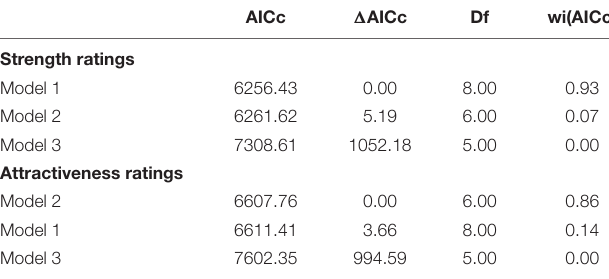
TABLE 7 | Information criteria for the general linear mixed